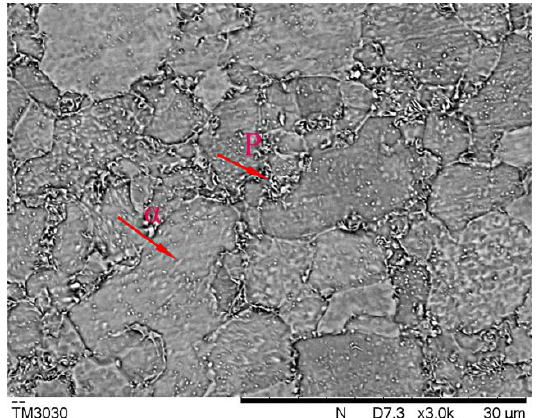
Figure 1. SEM microstructure of USIBOR ® 1500 high-strength steel after rolling and annealing.